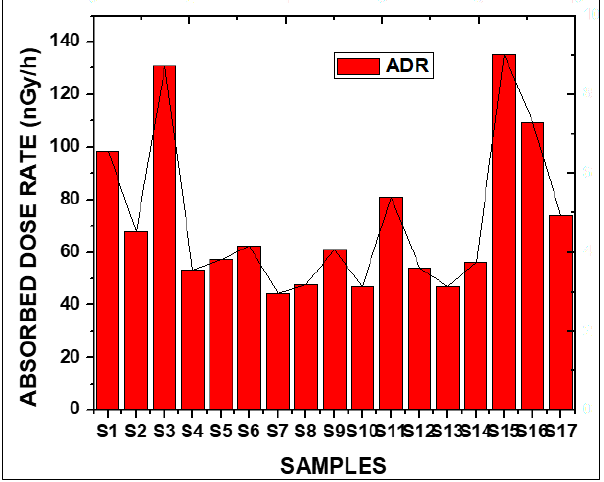
Figure 3: Representation of Absorbed Dose Rate in this